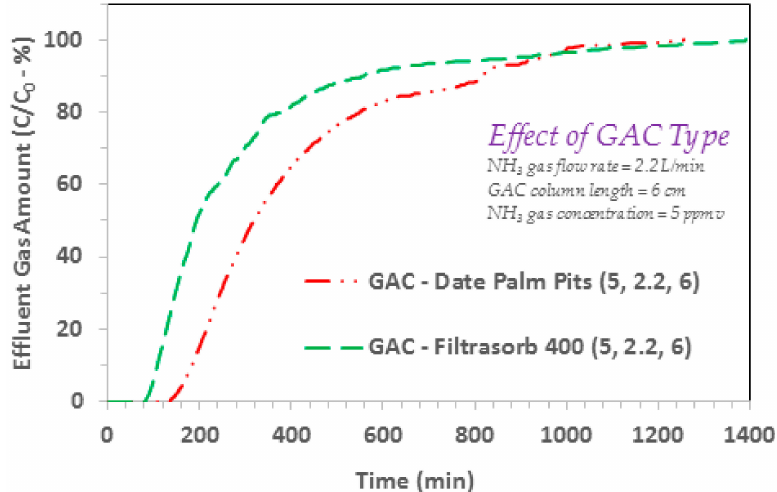
Figure 6. E ff ect of GAC type on the adsorption breakthrough curve profile of ammonia gas on to GAC produced from date palm pits ( SSA BET 822 m 2 / g for date palm pits based GAC and 1100 m 2 / g for Filtrasorb 400 GAC; ammonia / NH 3 gas flow rate = 2.2 L / min; influent ammonia / NH 3 gas concentrations 5 ppmv; GAC column length = 6 cm; GAC bed dia. 6.35